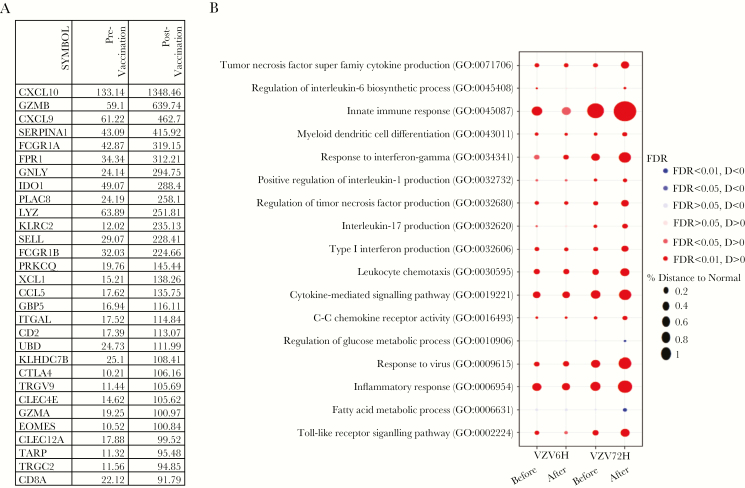
Pathways upregulated in the skin after Zostavax vaccination. A, Table showing the top 30 genes upregulated at 72 hours after varicella zoster virus (VZV) challenge before and after vaccination. B, Kyoto Encyclopedia of Genes and Genomes and Gene Ontology collection, as well as a curated skin-related collection, were interrogated, and the most relevant pathways among them with a false-discovery rate (FDR) of <0.05 are presented. Bubble plot representing the pathways upregulated in the skin at 6 hours and 72 hours after VZV challenge, before and after Zostavax vaccination. The area of each circle is proportional to the differences in the gene set variation analysis–derived pathway scores between VZV-challenged and unchallenged skin in each group. Colors indicate the direction of dysregulation (red, up; blue, down). Color intensity represents the strength of the dysregulation determined by the FDR.